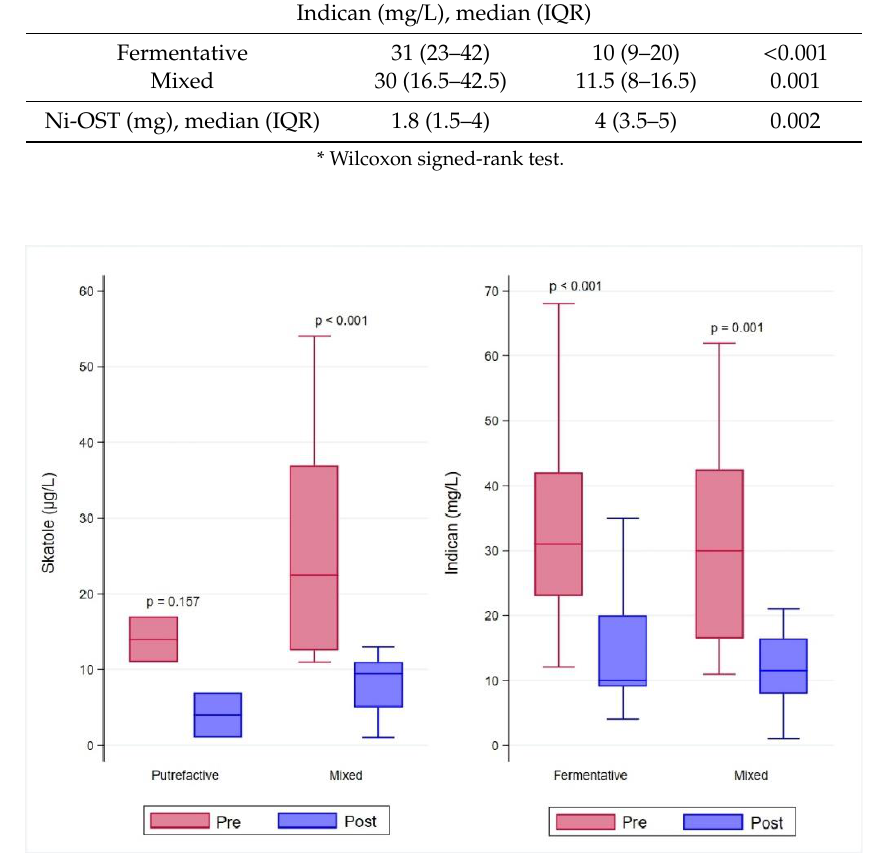
Figure 3. Comparison of pre- and post-treatment levels of urinary dysbiosis markers. Data are stratified for dysbiosis type based on the pre-treatment levels of skatole and indican.